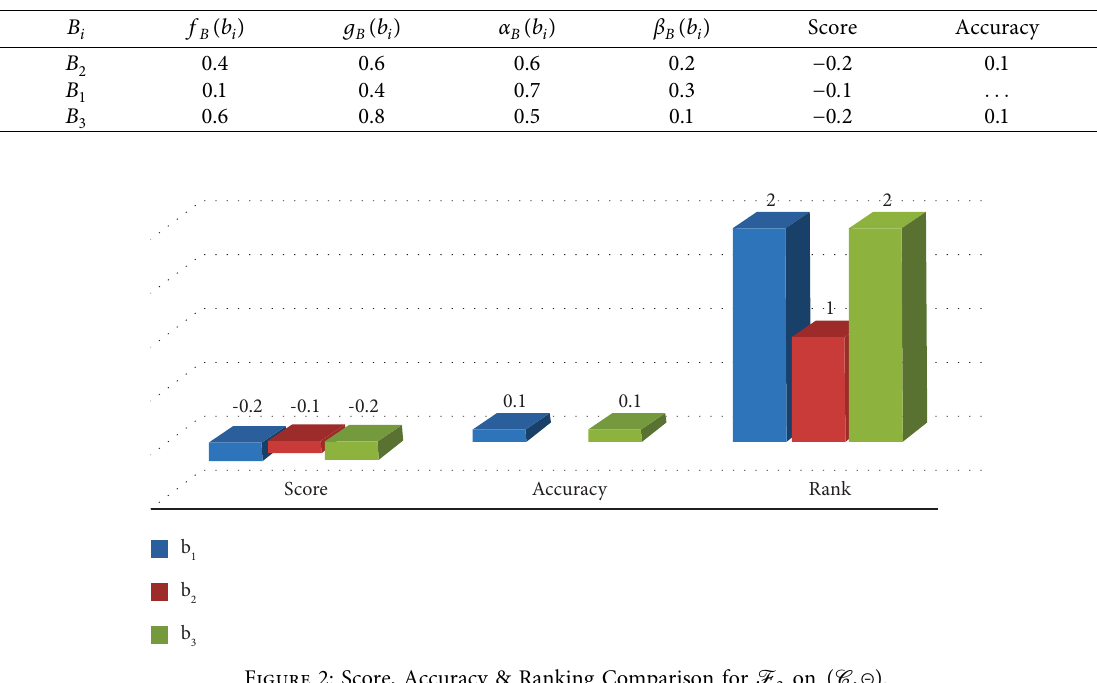
Figure 2: Score, Accuracy & Ranking Comparison for F